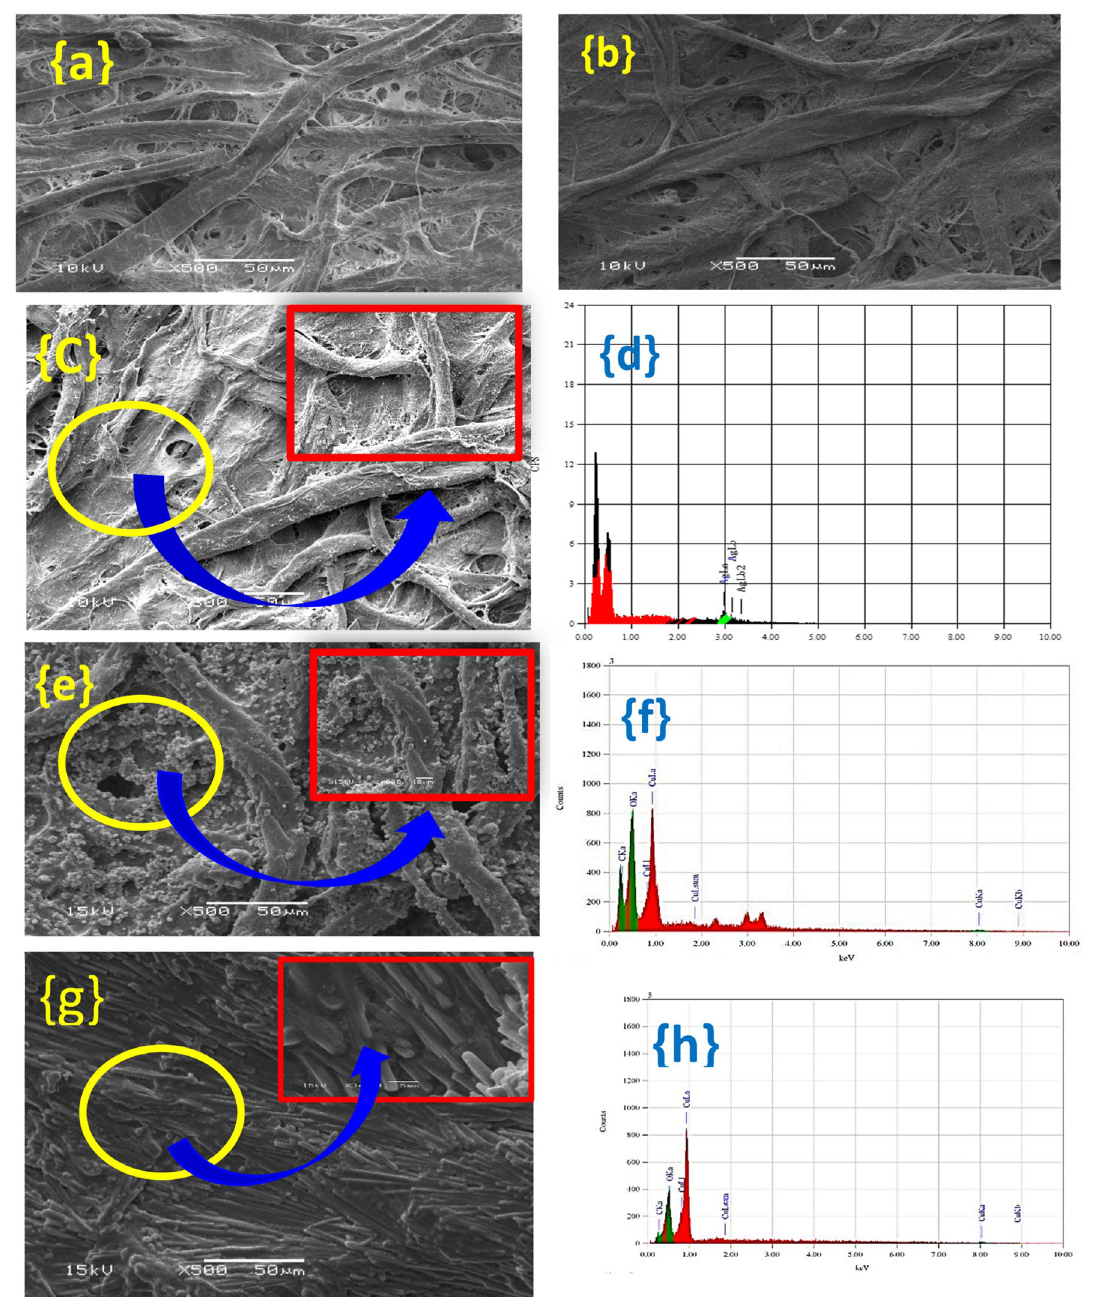
Figure 3. SEM images of modified cellulosic FP surfaces with different layers ( a ) Pure cellulosic FP, ( b ) PD layer, ( c ) Ag NPs layer, ( e ) Cu NPs layer, and ( g ) Cu(OH) 2 nanorods layer. EDX analysis of ( d ) Ag layer, ( f ) Cu layer and ( h ) Cu(OH) 2